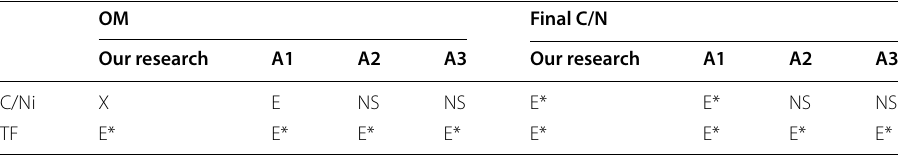
Table 18 Summary of OM and final C/N according to several authors